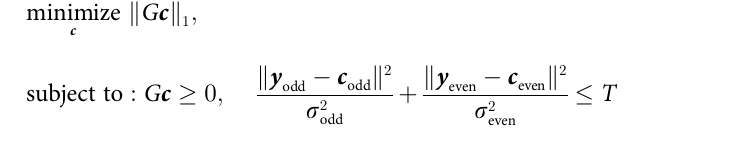
S1 Fig. Neural footprints sorted by increasing reconstruction loss for 16×16 decimation. Structures that are smaller in size are more sensitive to